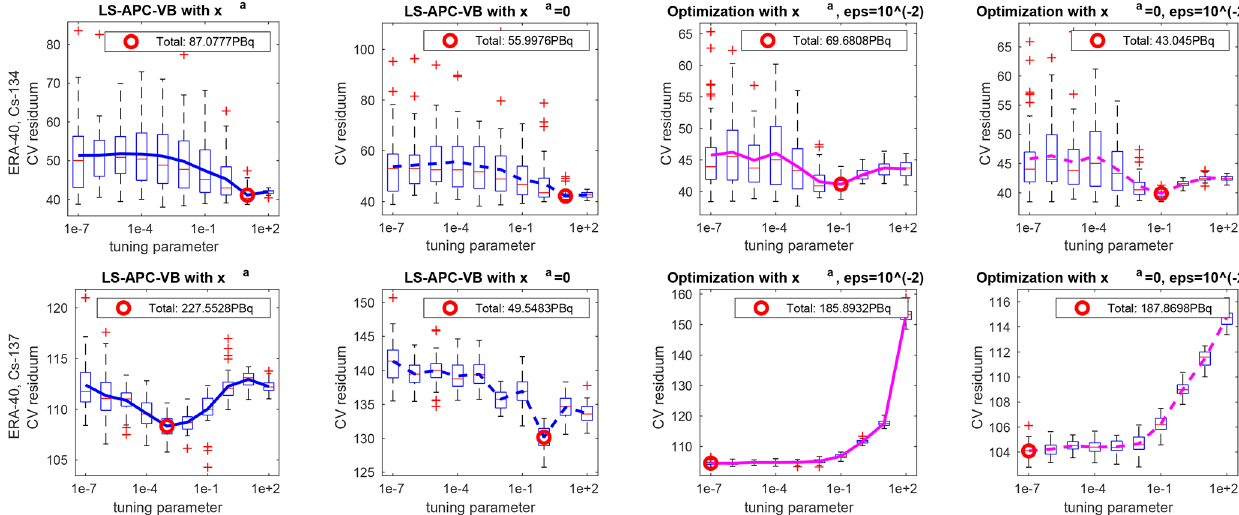
Figure 10. Cross-validation for Chernobyl Cs-134 (top panels) and Cs-137 (bottom panels) source terms using FLEXPART driven with ERA- 40 meteorological reanalyses. Optima in the sense of cross-validation are denoted using red circles with total estimated releases reported in the